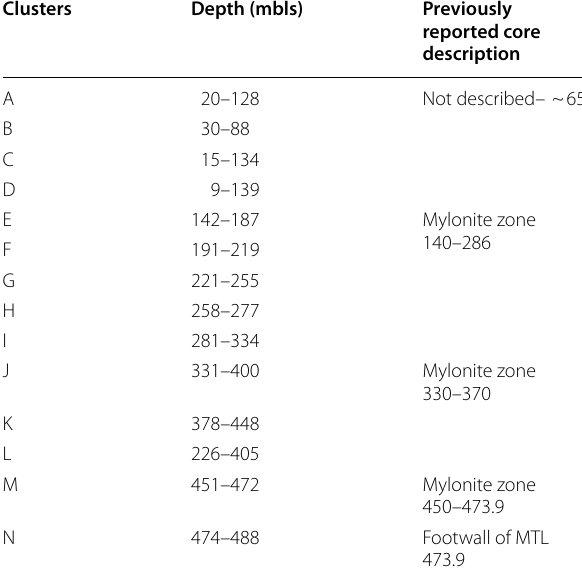
Table 2 Clustering results for site ITA